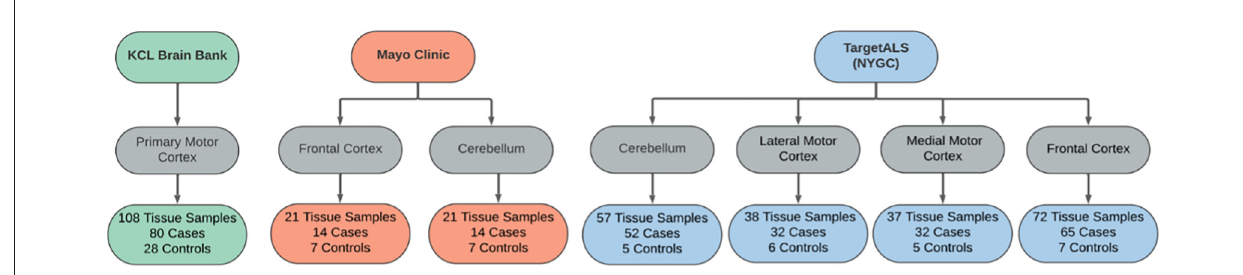
FIGURE2 Sample overview across the RNAseq datasets used in the differential expression analyses. Datasets were obtained from the KCL Brain Bank (green), Mayo Clinic (orange), and TargetALS (NYGC; blue).